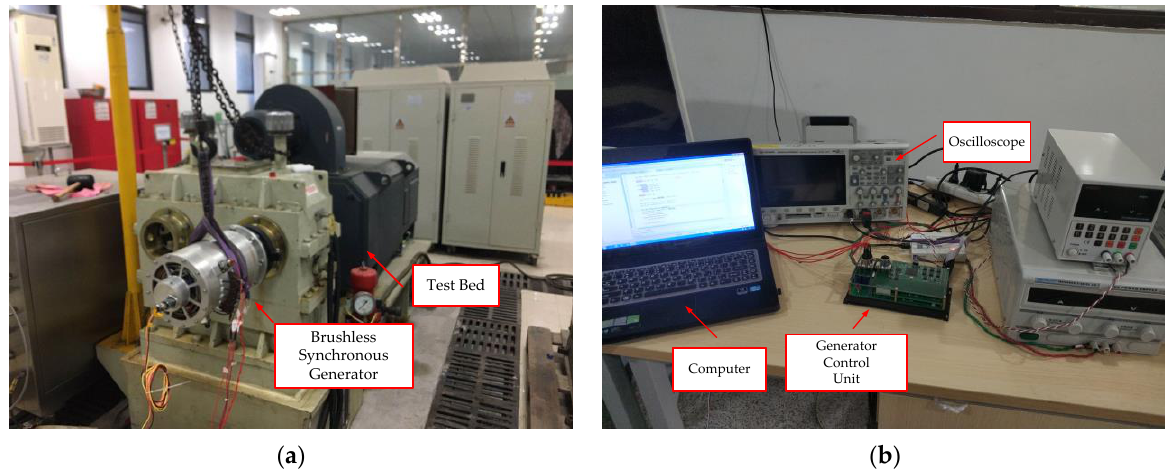
Figure 16. Experimental platform for the power generation system: ( a ) BSG and the testbed; ( b ) GCU and other equipment.